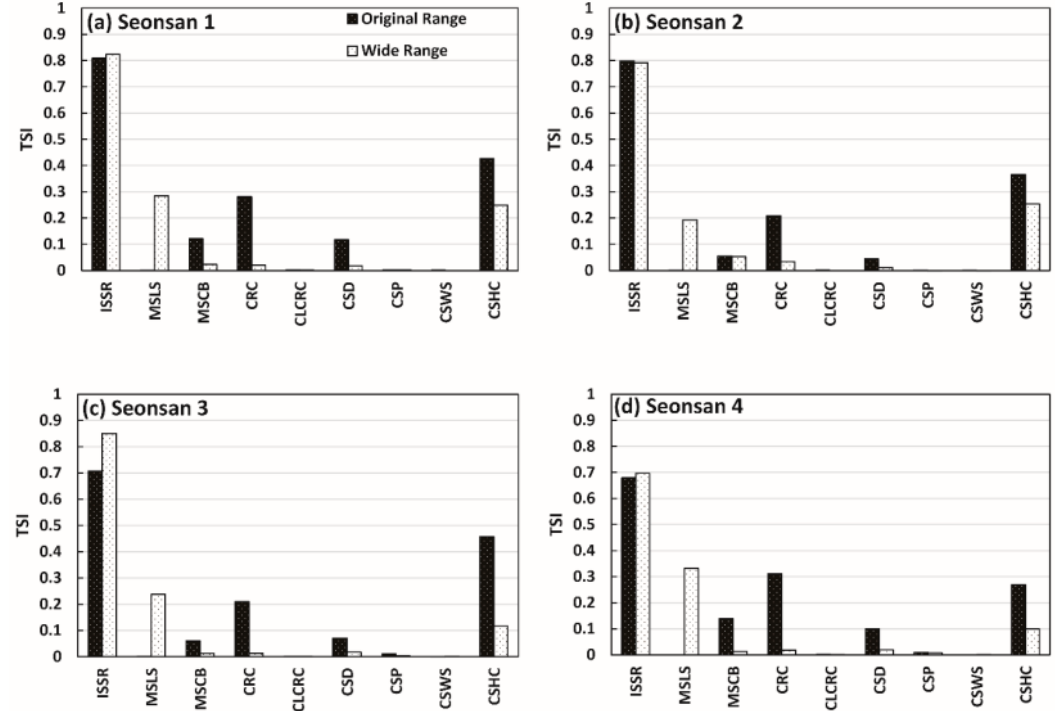
Figure 10. Sensitivity changes of parameters for different parameter ranges for the Seonsan catchment (using NSE* objective function): ( a ) Seonsan 1; ( b ) Seonsan 2; ( c ) Seonsan 3; ( d ) Seonsan 4.